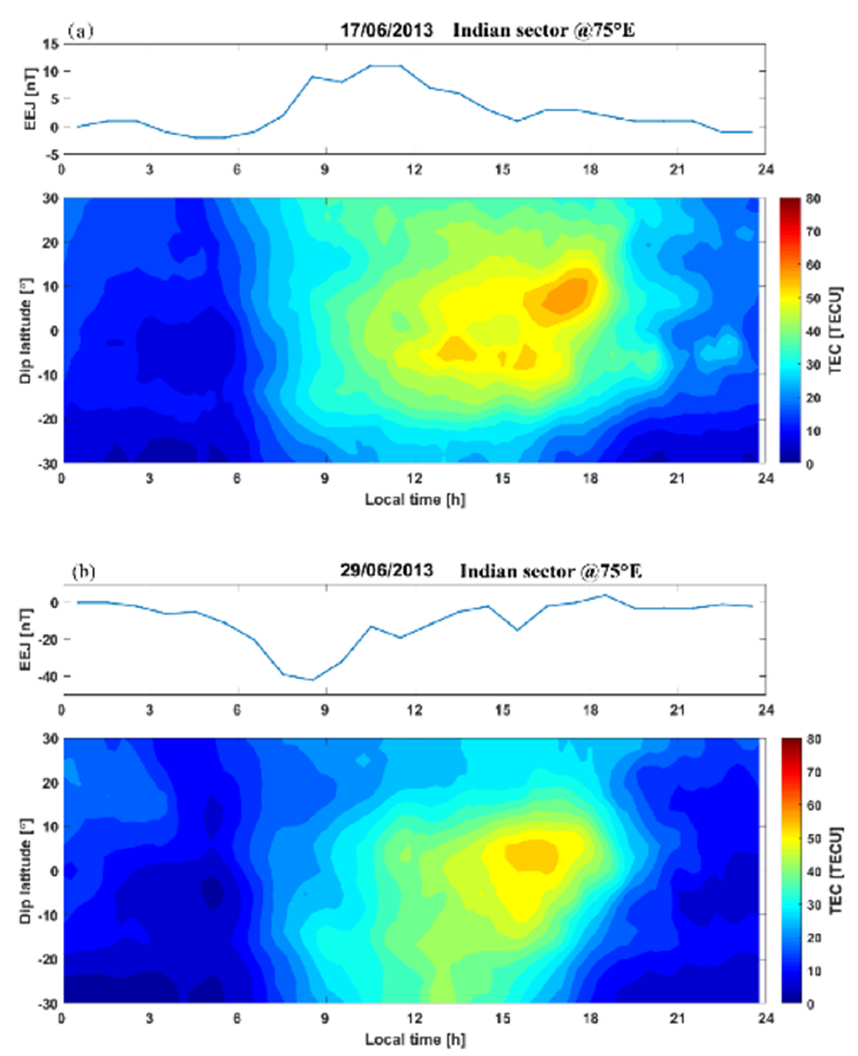
Figure 1. Two examples of the GPS-measured TEC map at Indian sector during ( a ) a weak EEJ day and ( b ) a CEJ day.